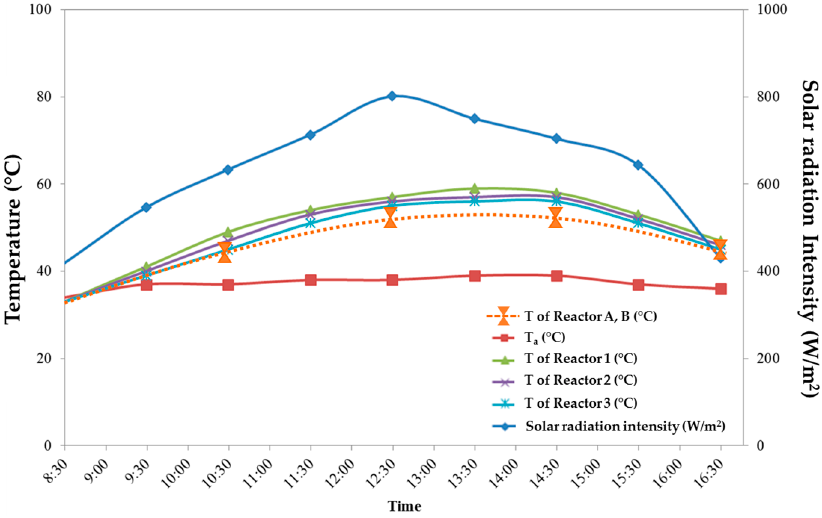
Figure 4. Plots of solar radiation intensity, ambient air temperature (T a ), and reactor temperature during operation time from 08:30 AM – 4:30 PM.